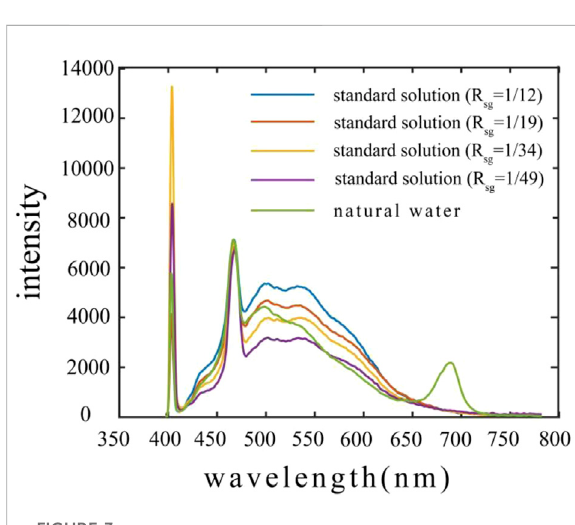
FIGURE 3 The spectra of standard solutions and natural water (vertical direction presents wavelength, horizontal direction presents spectral intensity, the green line presents natural water of COD = 8 mg/L collected from Riyue lake, and other color presents standard solutions under different